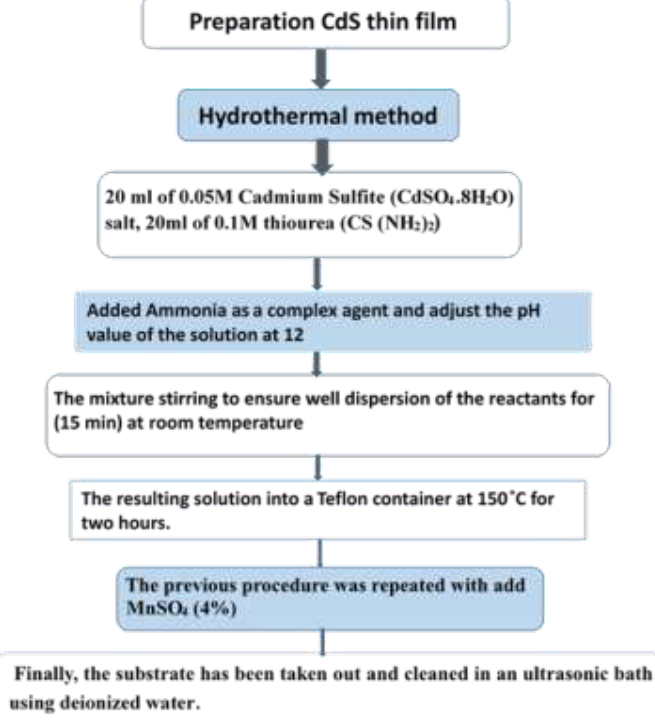
Figure1 : Schematic diagrams of the preparation of CdS thin films a procedure of pure CdS, and procedure of doped